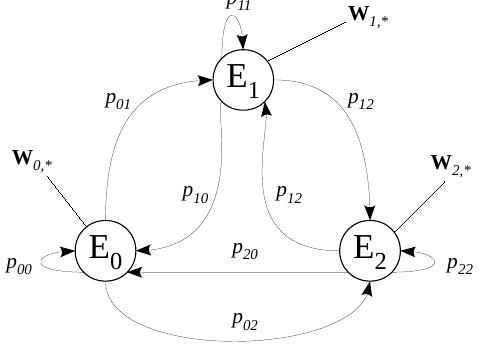
Figure 2. A three-state Hidden Markov